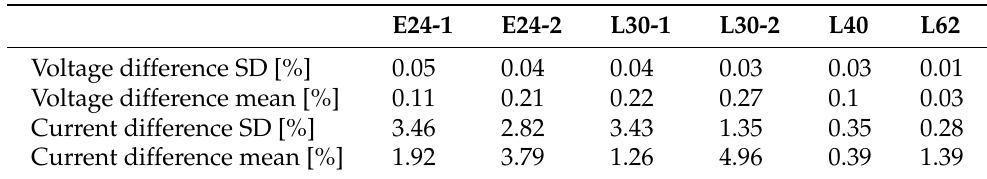
Table 5. Standard deviation and mean values of the percentage difference during constant current phase between EE and BMS